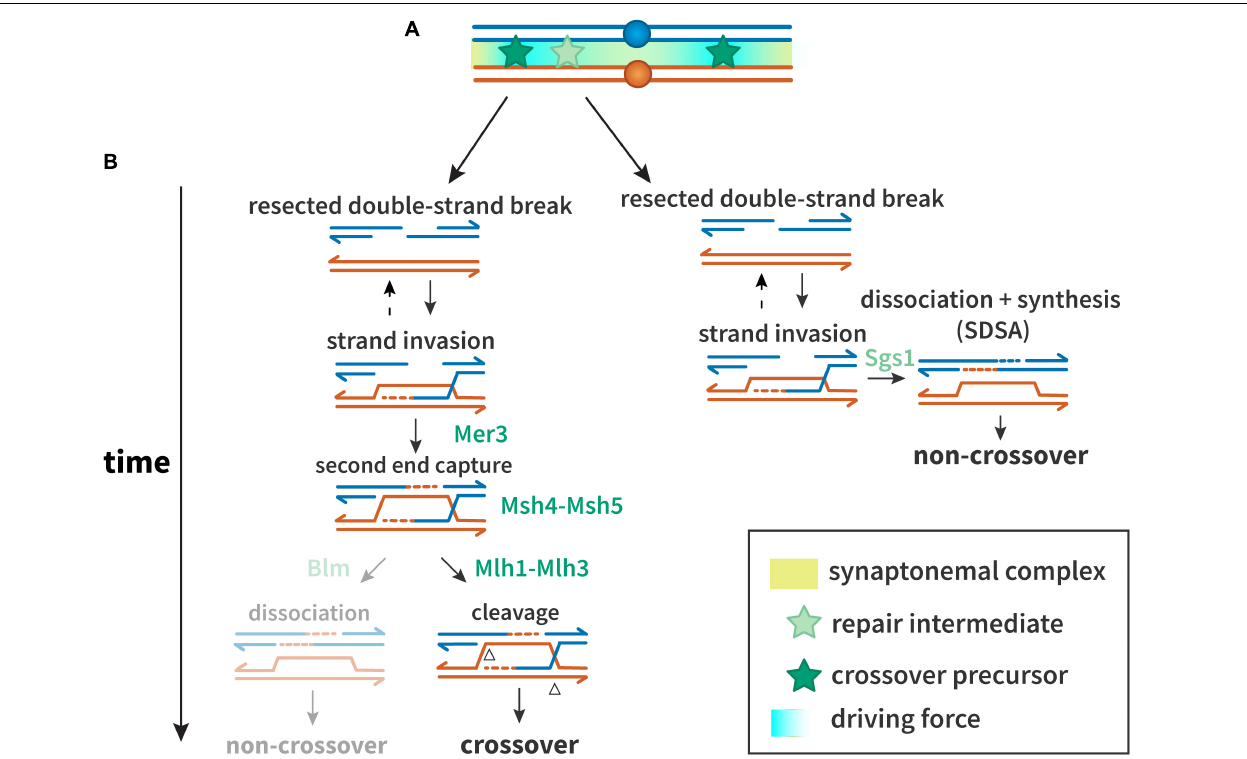
FIGURE 1 | Proteins and mechanisms of crossover interference. (A) A driving force (teal), potentially protein aggregation or mechanical stress, results in designation of crossover precursors (stars, dark green) at spaced intervals. Repair intermediates that do not experience sufficient driving force (stars, light green) are not so designated, and become non-crossovers. (B) Interference at the DNA level. Crossover precursors are processed through the class I crossover pathway, involving the ZMM proteins. Mer3 promotes second end capture, and Msh4–Msh5 clamp to and stabilize branched molecules to prevent their dissociation and to recruit Msh1–3. Intermediates are resolved by Mlh1–Mlh3 to generate crossovers. Non-crossovers in yeast are thought to be exclusively processed through the synthesis-dependent strand annealing (SDSA) pathway, promoted by Sgs1. In other organisms, the Sgs1 ortholog Blm may also promote formation of non-crossovers after second end